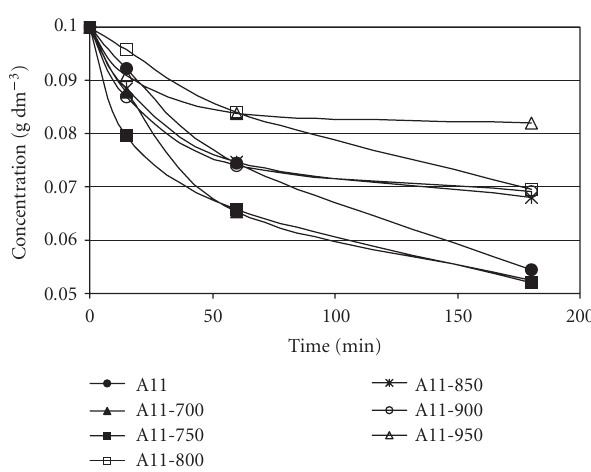
Figure 2: Changes in concentration of phenol during the photocat- alytic reaction for A11 photocatalyst samples. Initial concentration of phenol − 0 . 1gdm − 3 , photocatalyst amount − 0 . 2gdm − 3 .